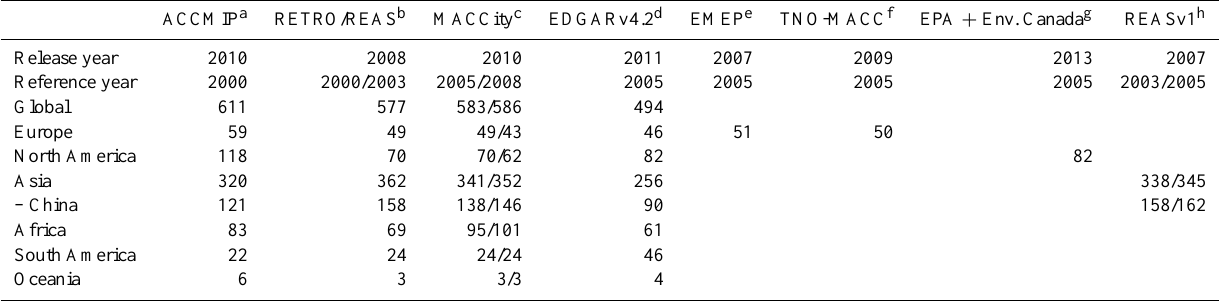
Table 1. Global and regional CO anthropogenic emission totals from recent bottom-up inventories in teragrams per year. All data except from EPA and Environmental Canada are available online from the Emissions of atmospheric Compounds & Compilation of Ancillary Data (ECCAD) database (http://eccad.sedoo.fr/).